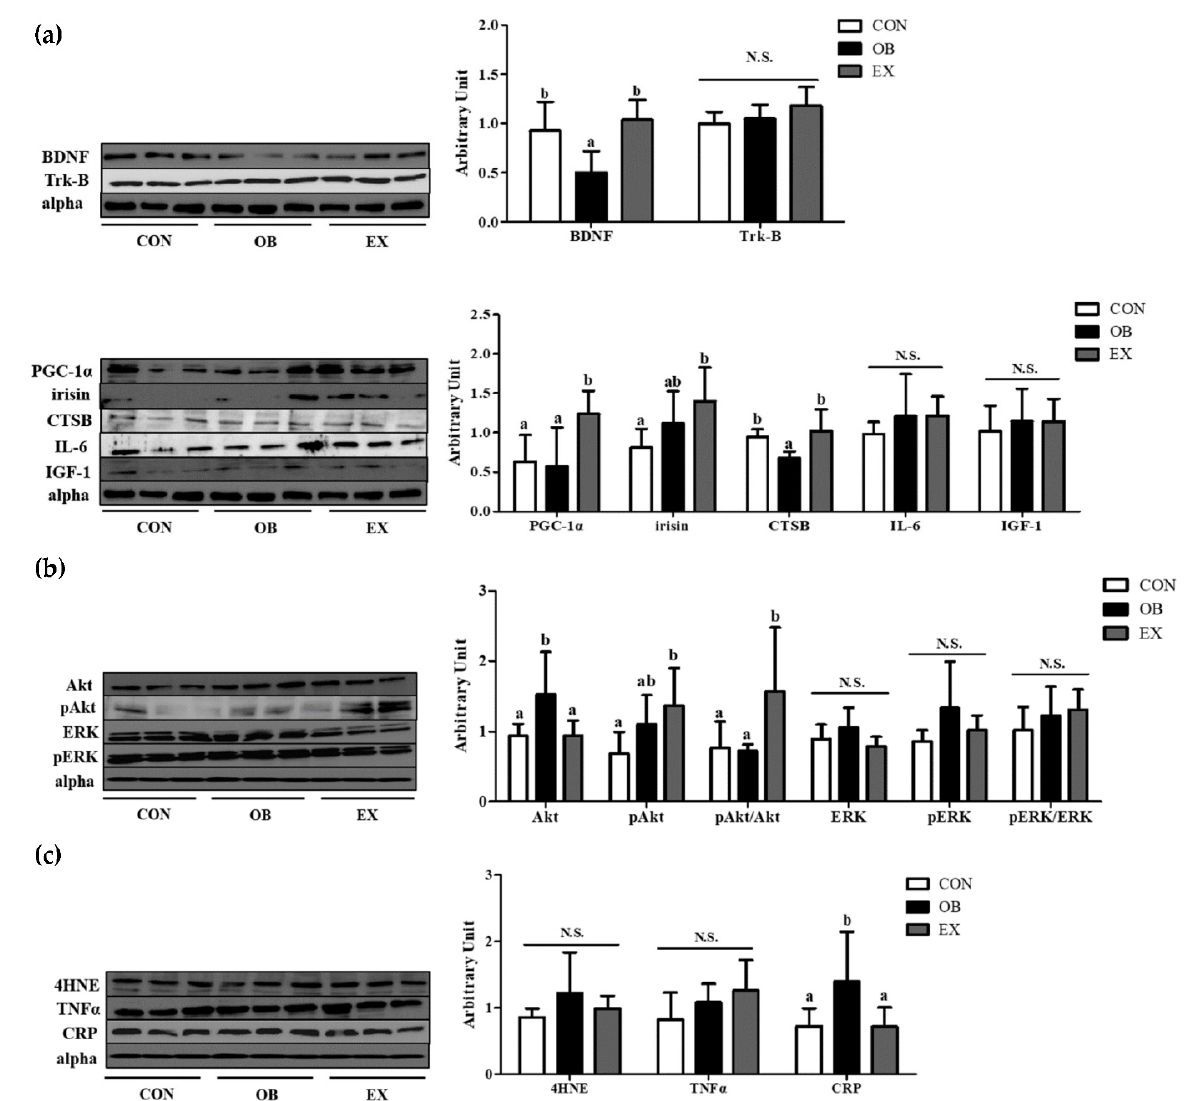
Figure 6. Effects of resistant exercise on hippocampal ( a ) cognitive function-related myokines and ( b ) energy metabolism and ( c ) oxidative stress and inflammation in sarcopenic obese mice. Values are means ± SEM ( n = 5~6). Mean values with the same superscript letter (a and b) are not significantly different ( p < 0.05). BDNF: brain-derived neurotrophic factor, Trk-B: tropomyosin receptor kinase B, PGC-1 α : peroxisome proliferator-activated receptor-gamma coactivator 1-alpha, CTSB: cathepsin B, IL-6: interleukin-6, IGF-1: insulin-like growth factor 1, Akt: protein kinase B, ERK1/2: extracellular signal-regulated kinases 1/2, 4HNE: 4-Hydroxynonenal, TNF- α : tumor necrosis factor-alpha, CRP: C-Reactive Protein. N.S.: no significance.